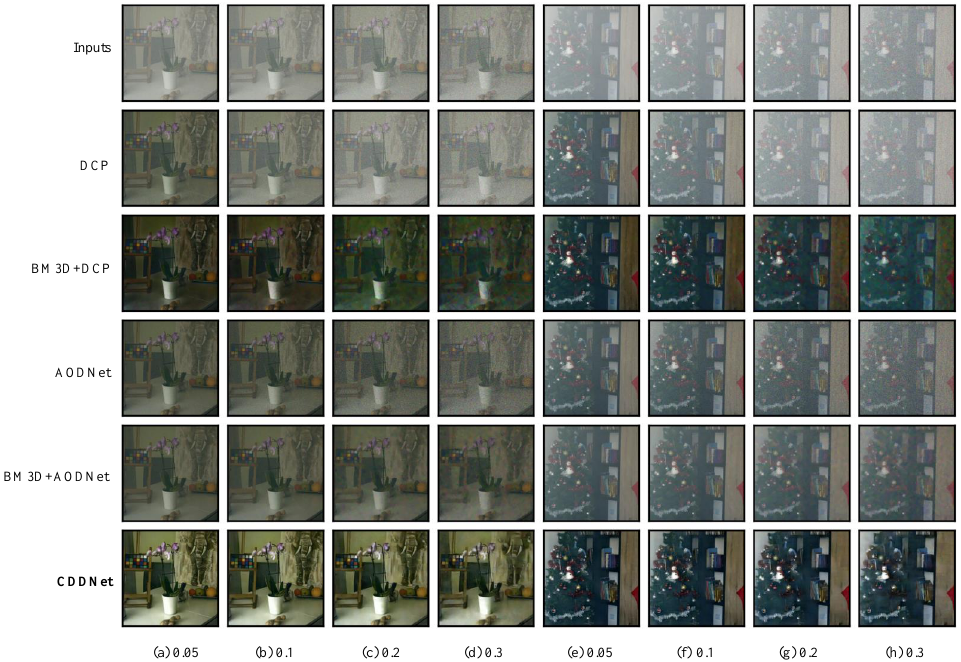
Figure 3. Challenging real hazy images from I-HAZE addressed with various methods. Table 1. PSNR and SSIM results of different methods under various noise levels with standard deviation varying among { 0.05,0.1,0.2,0.3 }